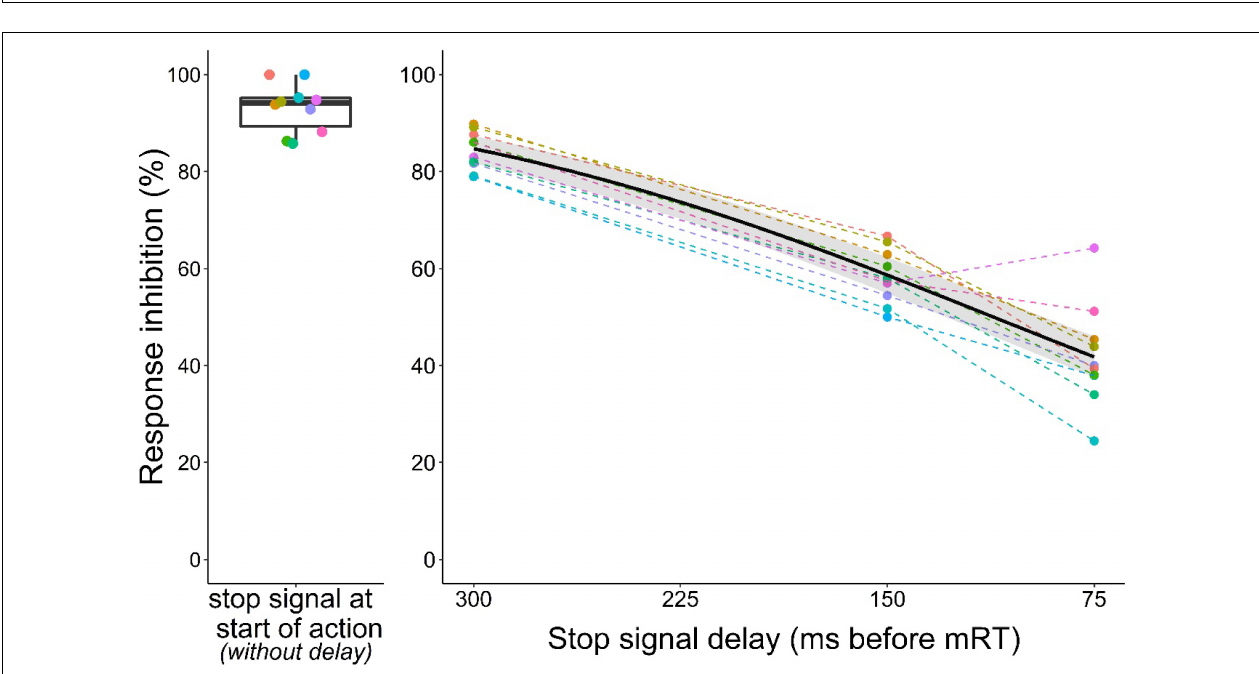
FIGURE 5 | Numbers of individual sessions and trials per day during the probe session phase of the experiment. Individual data are means. Group median values are 6.2 (A) and 160 (B) . Colors show the same individual. Box plots show median, 1st and 3rd quartile, and whiskers the 1.5 interquartile range. Data from n = 10 mice.